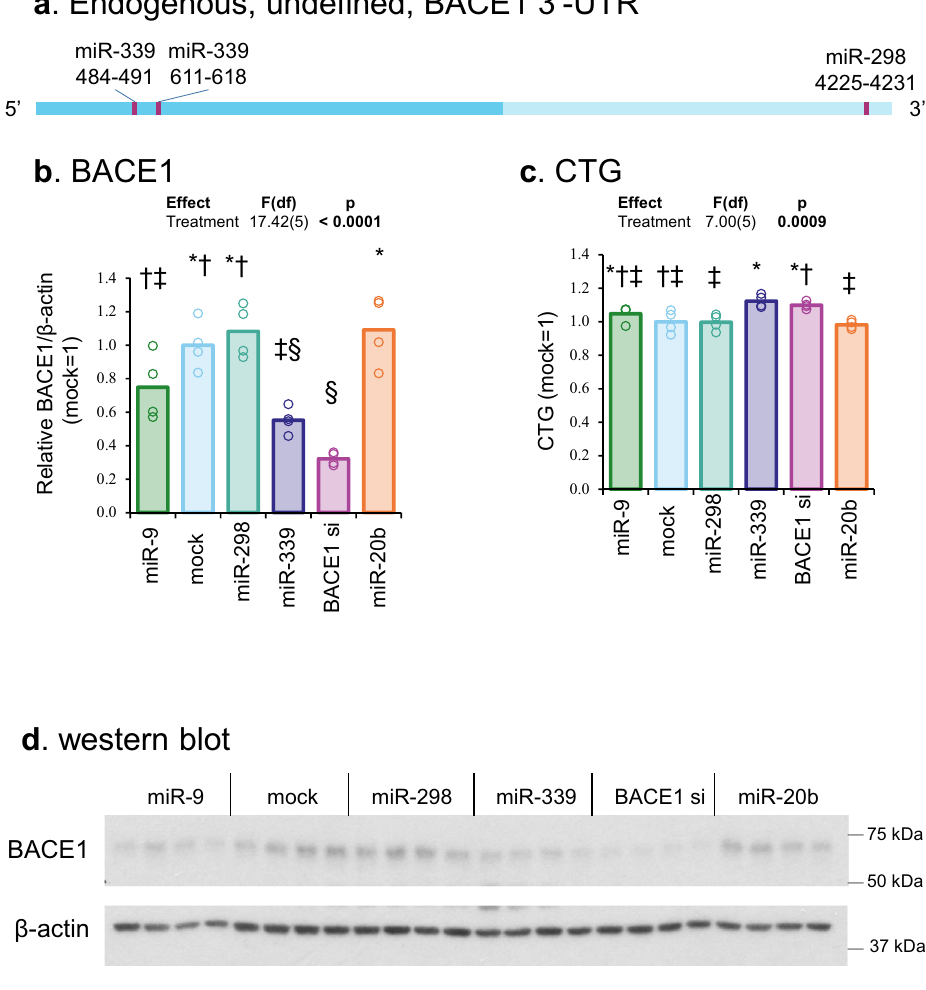
Figure 5. Effects of miR-298 and miR-339 on endogenous BACE1 levels in differentiated neuroblastoma cells. ( a ) Scale drawing of endogenous BACE1 mRNA undefined 3 ′ -UTR with miR-339 and miR-298 binding sites. Dash line represents potential truncation or alternation of BACE1 3 ′ -UTR. ( b ) Densitometric analysis. ( c ) CTG assay. Each letter represents a different group. ( d ) Western blotting of BACE1 and β-actin. Results of pairwise comparison of all treatments is shown by symbols. Treatments sharing a symbol did not significantly differ (p < 0.05). "(ns)" indicates no significant pairwise